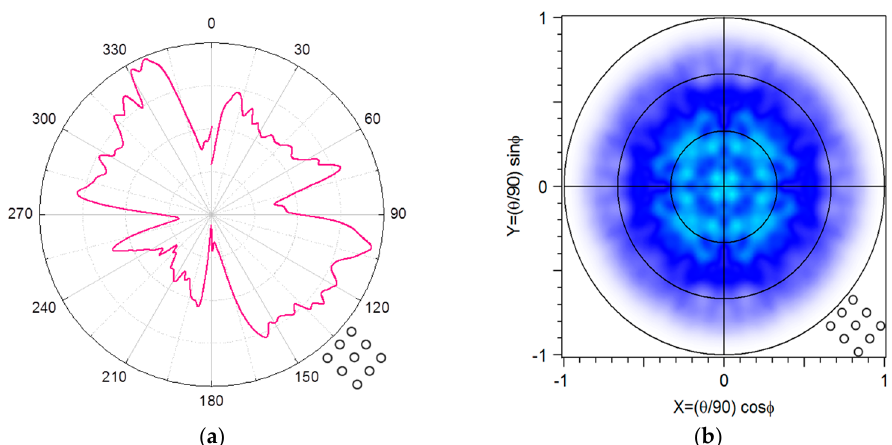
Figure 8. ( a ) Normalized radiation pattern shown as a contour graph for the selected constant intensity and ( b ) the polar projection of the simulated far field of 2D PhC LED.